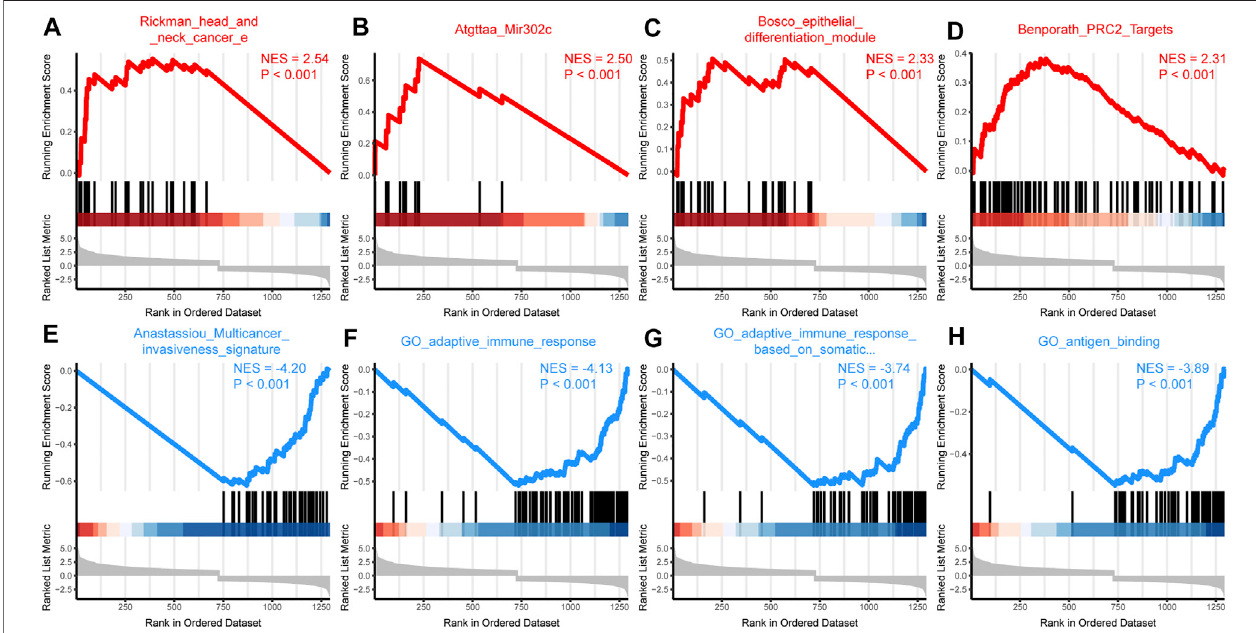
FIGURE 7 | GSEA enrichment analysis. (A – D) According to the NES value, the differentially expressed genes were enriched in the fi rst four pathways in the high SPOCD1expressiongroup.TheNESvaluerepresentsthenormalizedenrichmentfraction,andthehighertheNESvalueis,themoregenesareenrichedinthispathway. The p -valuere fl ectsthecredibilityoftheenrichmentresults; (E – H) AccordingtotheNESvalue,thedifferentiallyexpressed geneswereenrichedinthe fi rstfourpathways in thelowSPOCD1expression group. TheNES valuerepresentsthenormalizedenrichmentfraction,and thehigher theNES valueis,the moregenesare enriched in this pathway. The p -value re fl ects the credibility of the enrichment results. GSEA, gene set enrichment analysis; NES, normalized enrichment score; SPOCD1, SPOC Domain Containing 1.